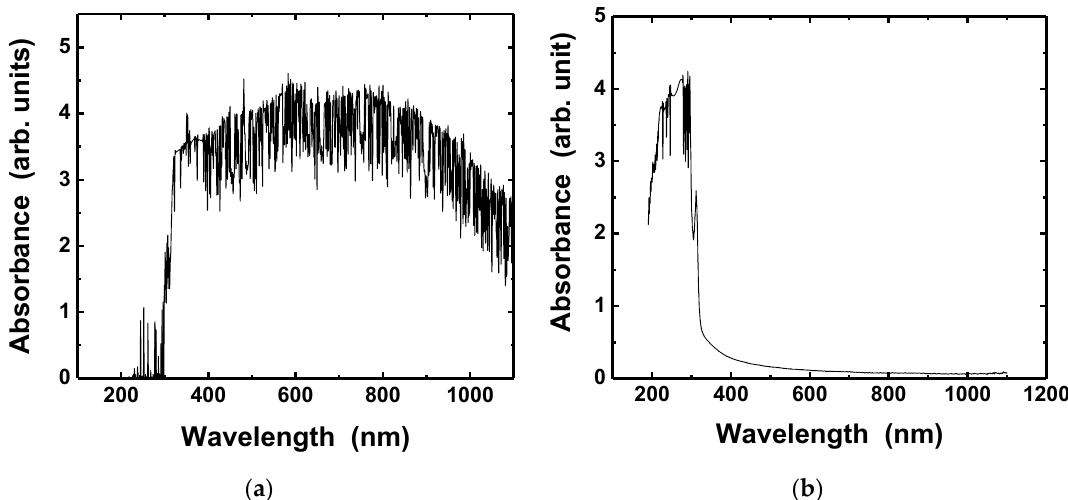
Figure 3. Absorbance spectra of the silver nanoparticle ink ( a ), PET substrate ( b ).